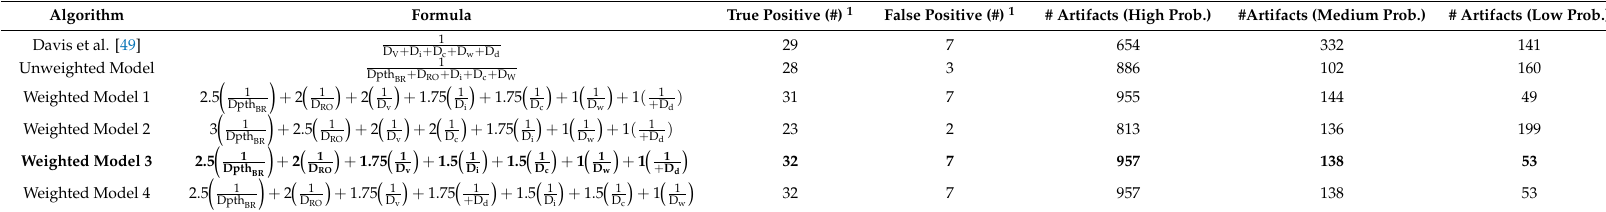
Table 4. The formulas and respective covariate weights for each predictive model and the results of ground truthed results from the Davis et al. [49] study in relation to each modified algorithm. The best performing model (bolded) produces the most true positives and highest overall values in areas with confirmed archaeological deposits (Table 5). D v = distance to vegetation (measured by SAVI) and D d = distance to